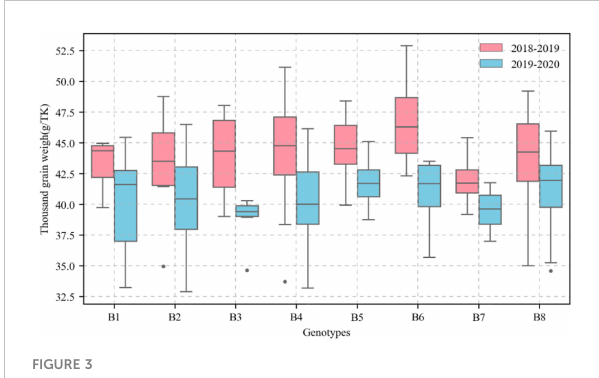
FIGURE 3 Distribution of thousand-kernel weight (TKW) of different genotypes of wheat in different growing seasons. Red box represents TKW in 2018-2019 growing season. Blue box represents TKW in 2019-2020 growing